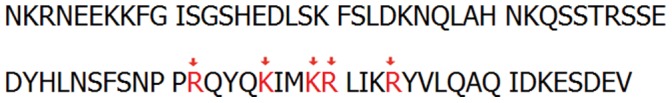
Amino acid senquence of TRPC6 fusion protein.Native rat TRPC6 801–878 amino acid sequence containing integrative binding site was investigated. Predicted important basic amino acids that were replaced by alanine are in red.